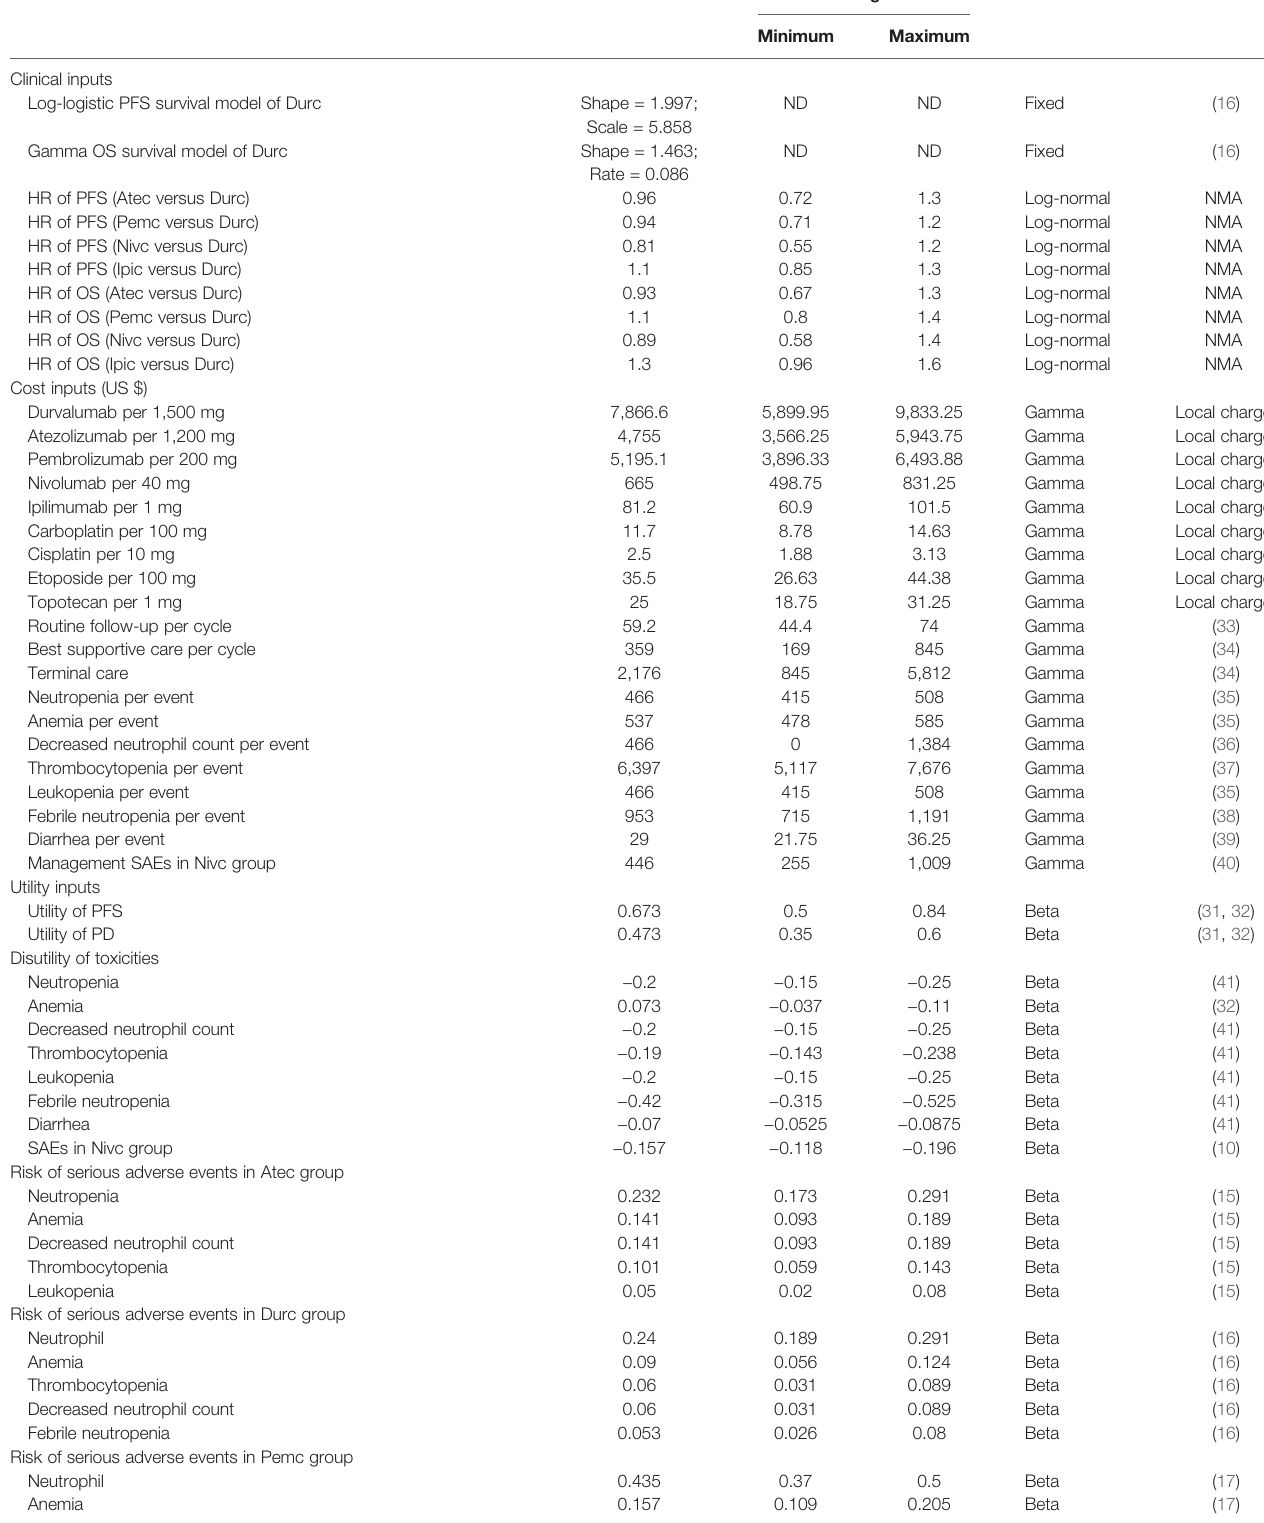
TABLE 1 | Model inputs: base-line values, ranges, and distributions for sensitivity